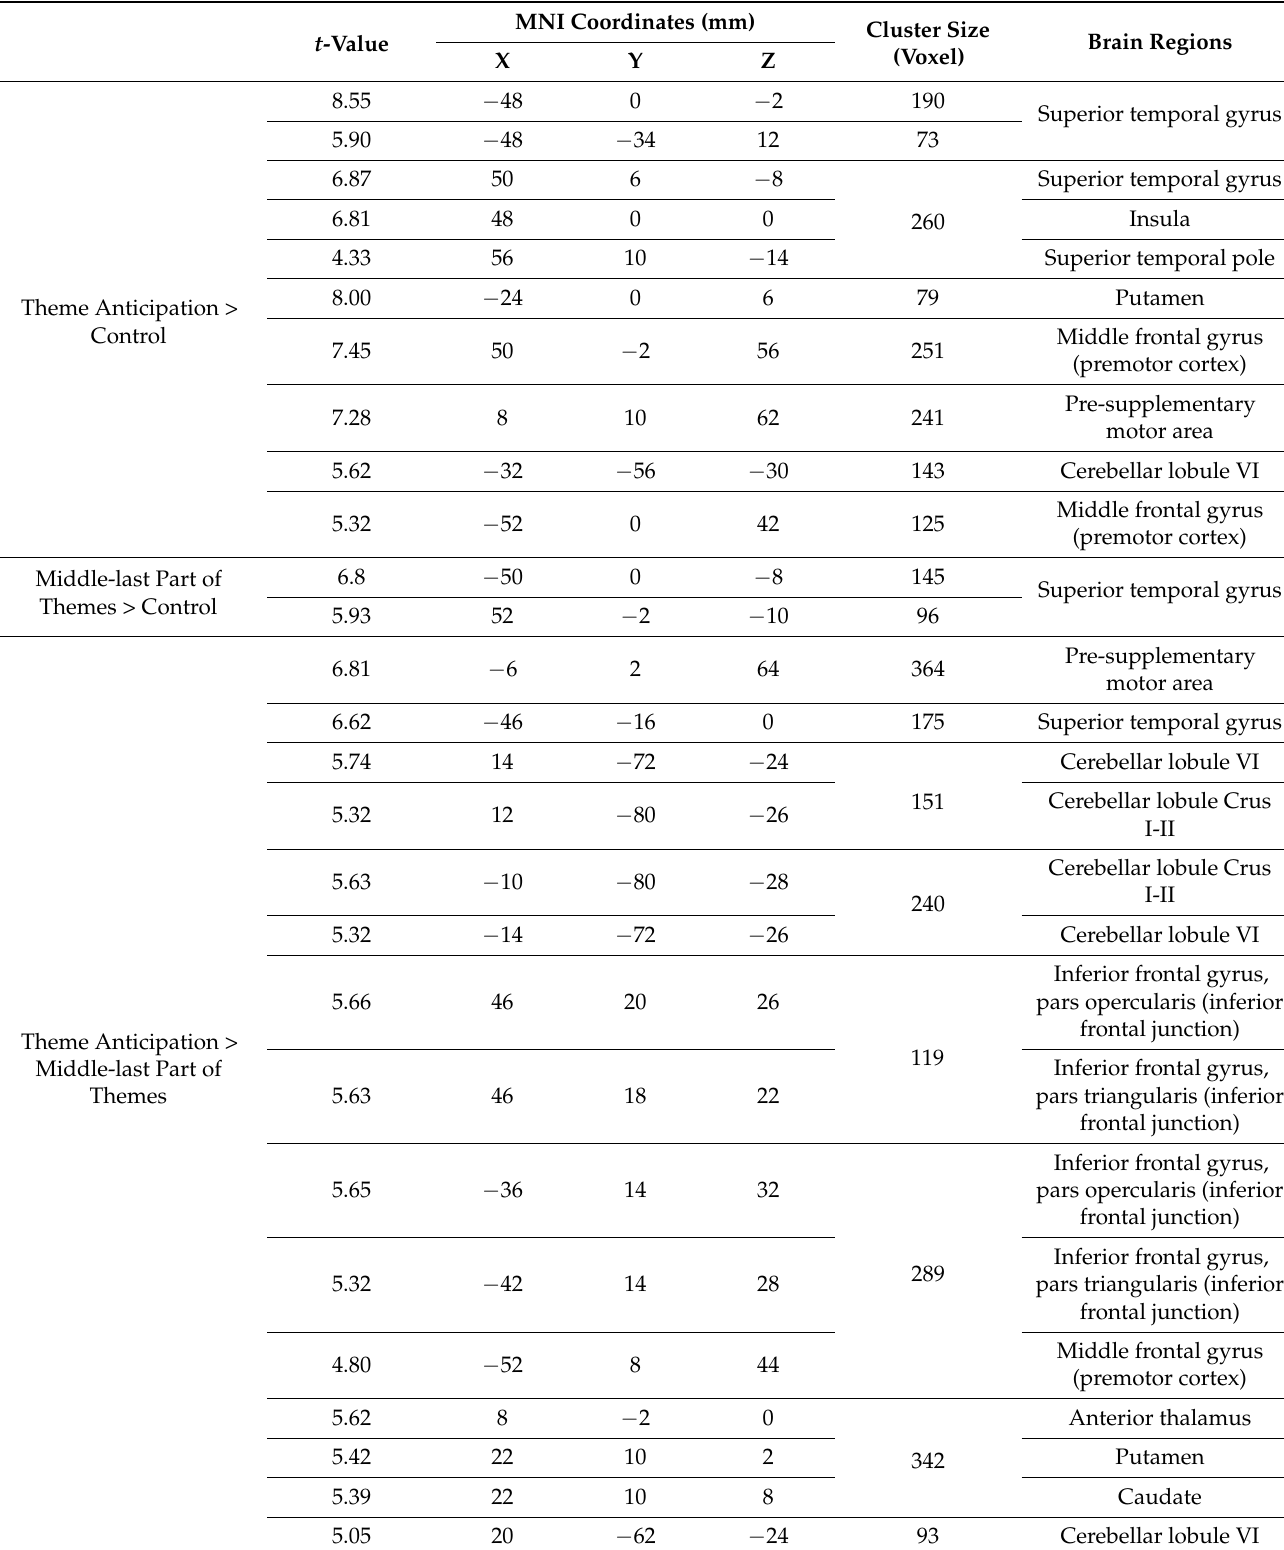
Table 1. Activation clusters for the contrasts of theme anticipation minus control, middle-last part of themes minus control, and theme anticipation minus middle-last part of